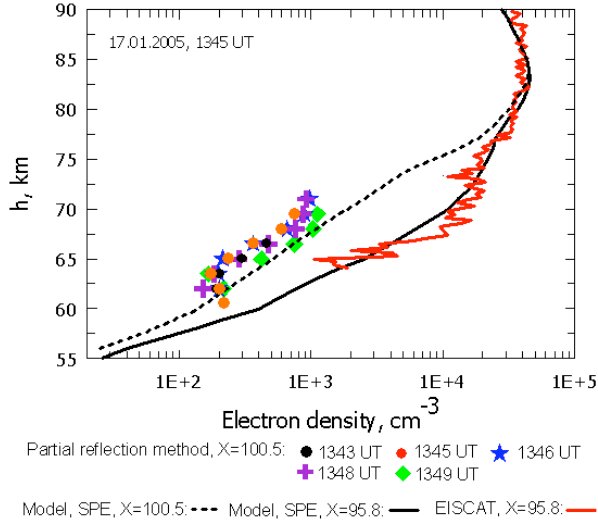
Fig. 9b. Electron density profiles measured (red curve and sym- bols) and calculated for the SPE on 17 January 2005 at 13:15UT for zenith angles 94.2 ◦ and 97.2 ◦ using the O, O 3 and NO profiles 4–6 in Fig. 1 (black curve).